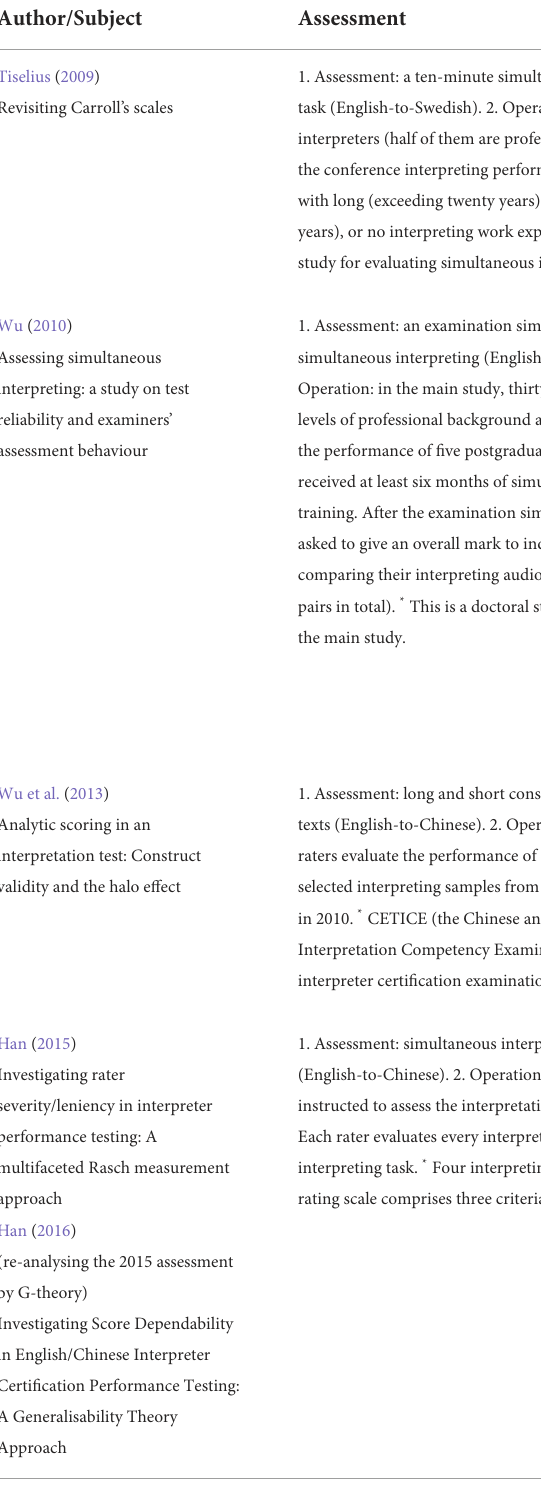
TABLE 2 Main studies on interpretation assessment